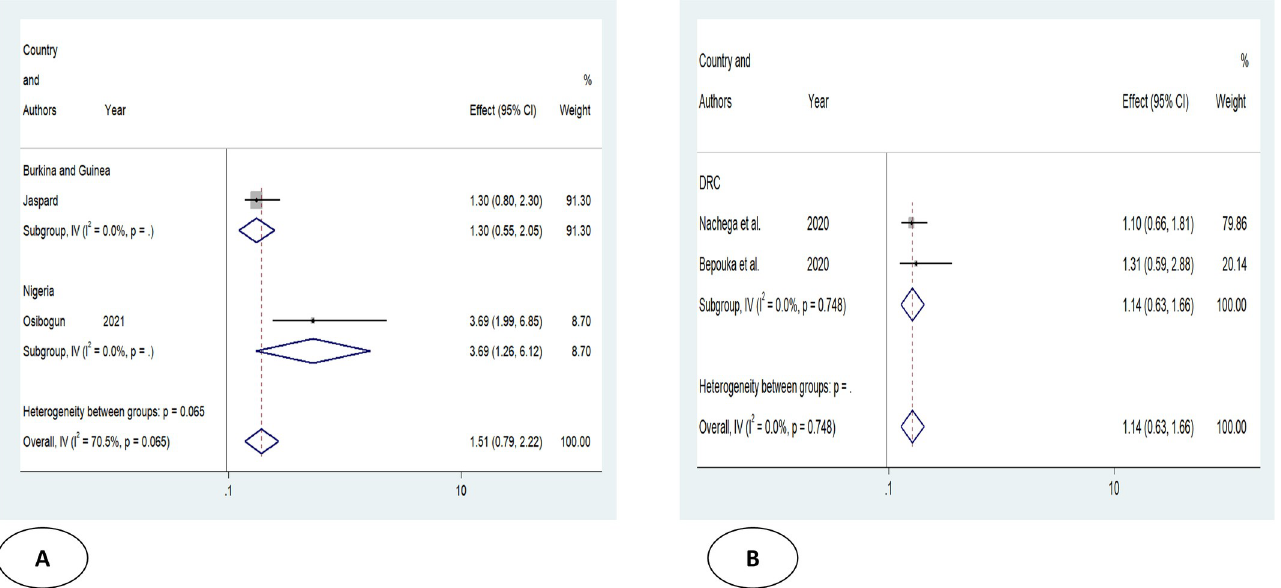
Pool OR statistics for age, diabetes mellitus, and dyspnea showed heterogeneity between the studies considered (I 2 with values of 82.7, 70.5, and 80.6, respectively. Subgroup analysis was not performed for diabetes mellitus and dyspnea as there were only two studies included. With